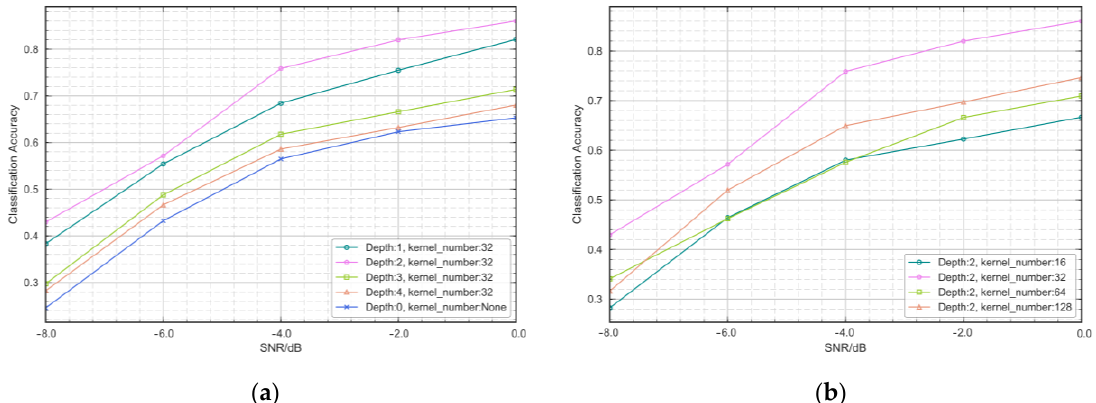
Figure 5. Correct recognition percentages versus SSTM structure.